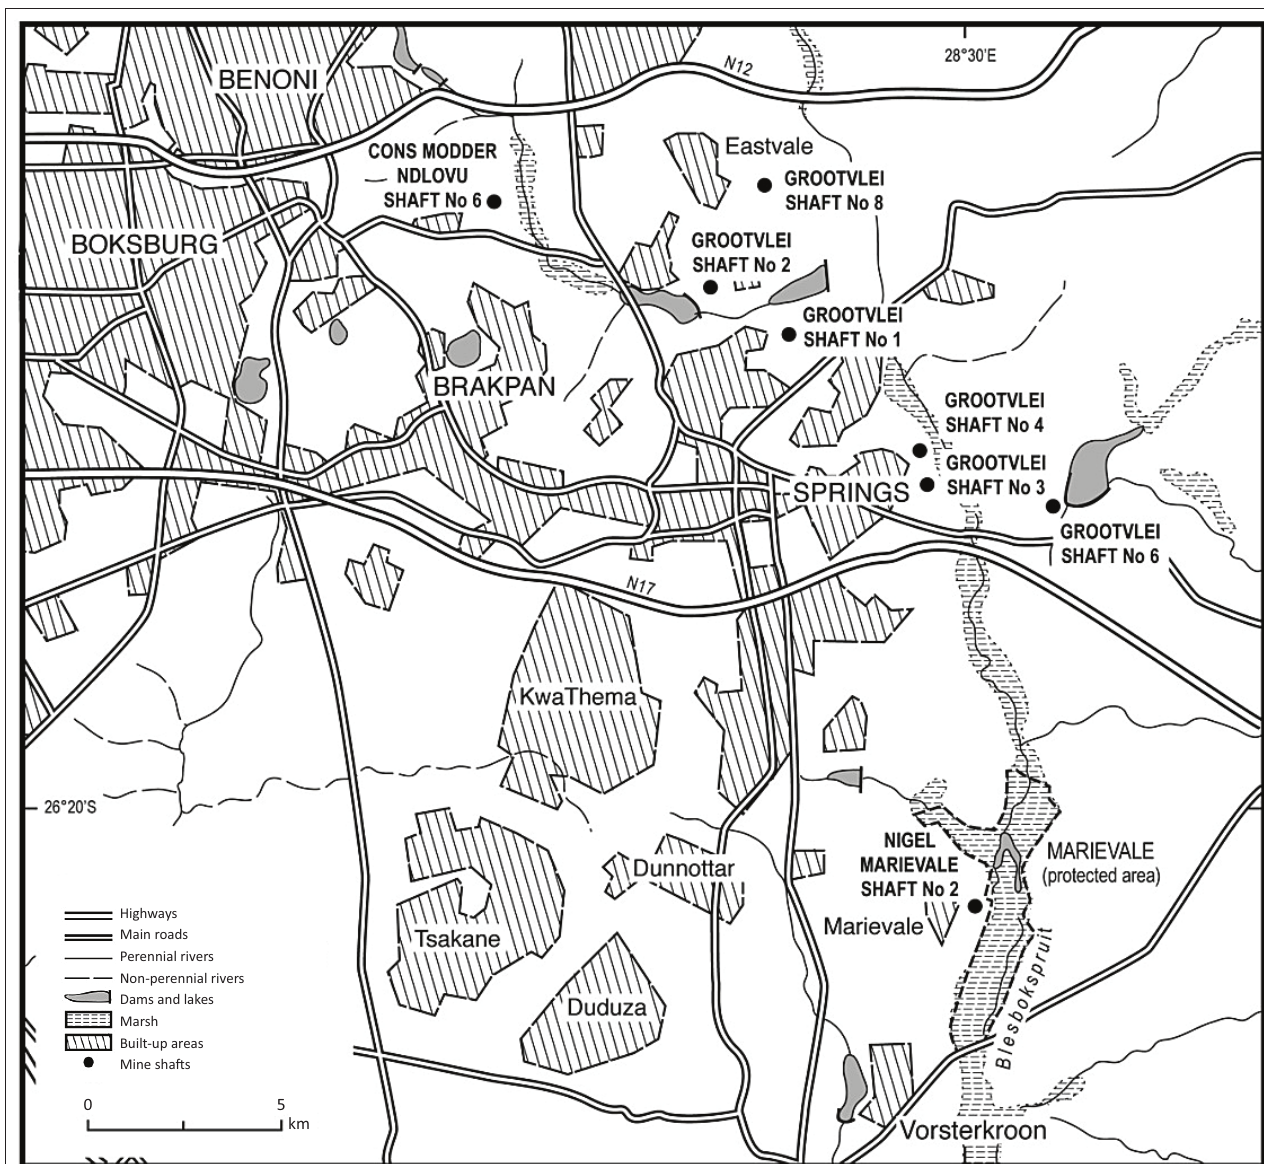
FIGURE 3: Location of Grootvlei mining shafts, the Blesbokspruit and Marievale Ramsar site. Ltd. (part of Bema Gold Corporation, Canada at the time) bought both mines, as well as neighbouring Nigel Mining Company’s mine (Salgado, 28/02/2011). Pamodzi Gold